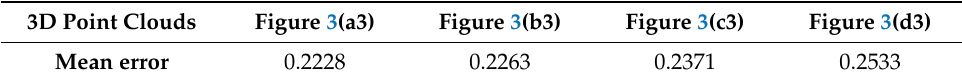
Table 2. Mean error of 3D points in Figure